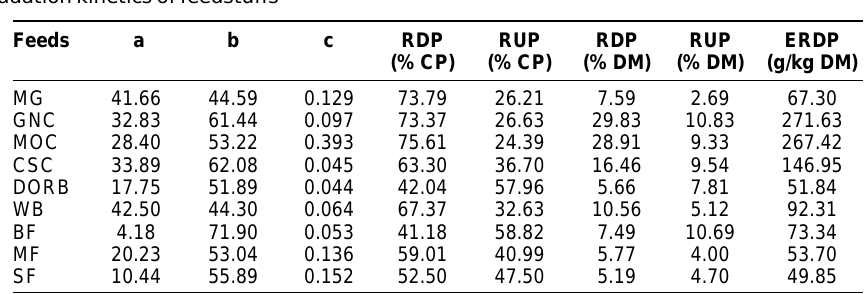
Table-5: CP degradation kinetics of feedstuffs Feeds